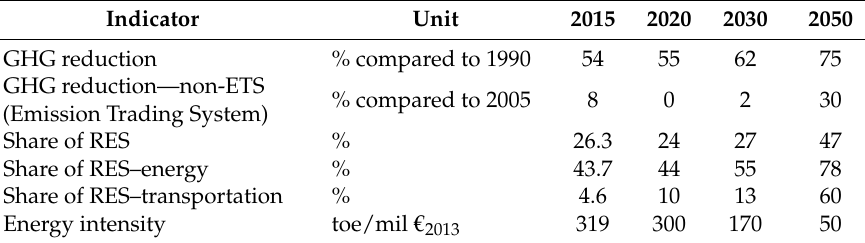
Table 5. Decarbonization targets for 2020, 2030, and